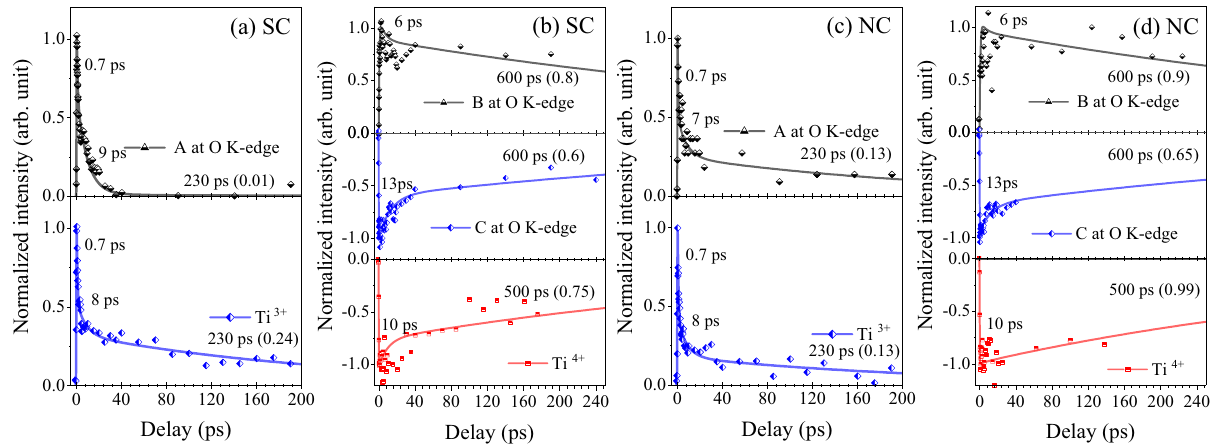
Fig. 7 The comparison of the time pro fi les between major features at the oxygen K-edge and the Ti L-edge. The comparison between the kinetic trace of ( a ) A at the oxygen K-edge and Ti 3 + at the Ti L-edge for SC, ( b ) B and C at the oxygen K-edge and Ti 4 + at the Ti L-edge for SC, ( c ) A at the oxygen K-edge and Ti 3 + at the Ti L-edge for NC, ( d ) B and C at the oxygen K-edge and Ti 4 + at the Ti L-edge for